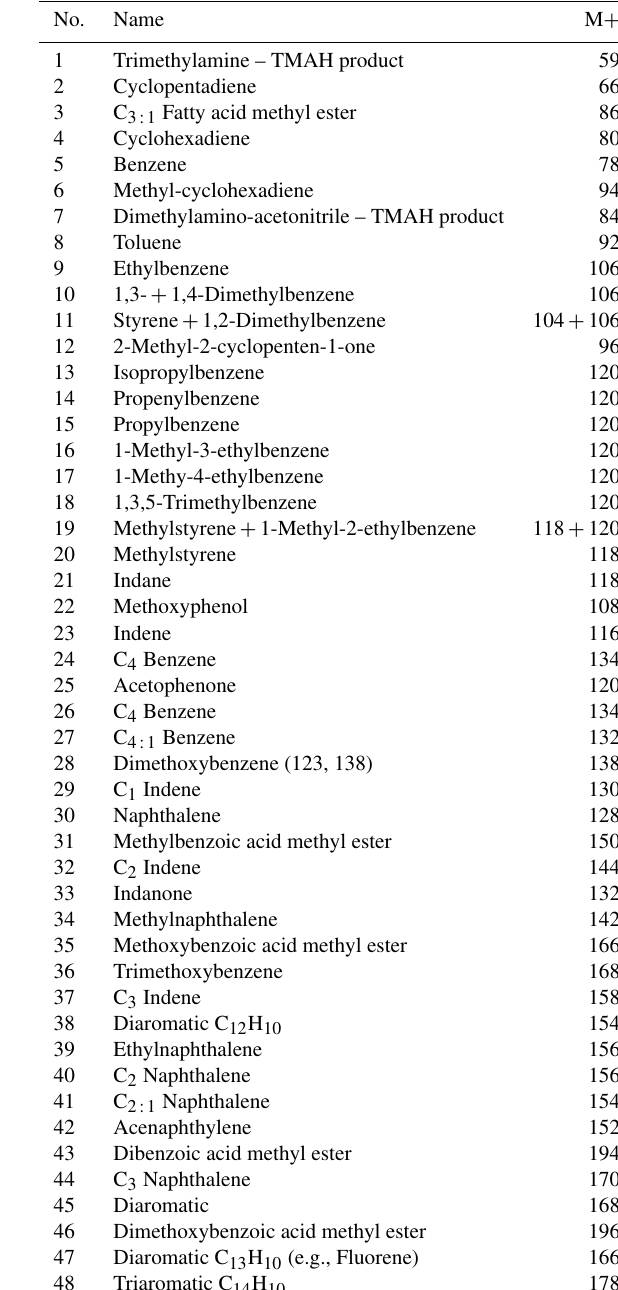
Table 2. Compounds identified in the thermochemolysate ∗